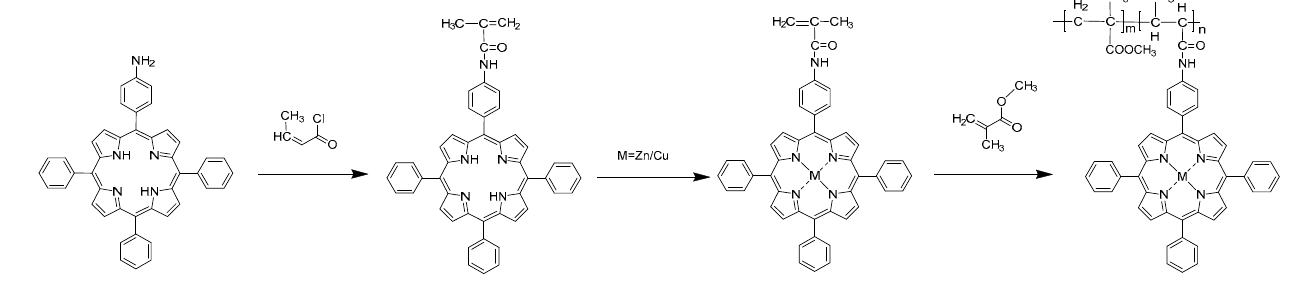
Figure 1. Synthetic route of metalloporphyrin/PMMA copolymer.